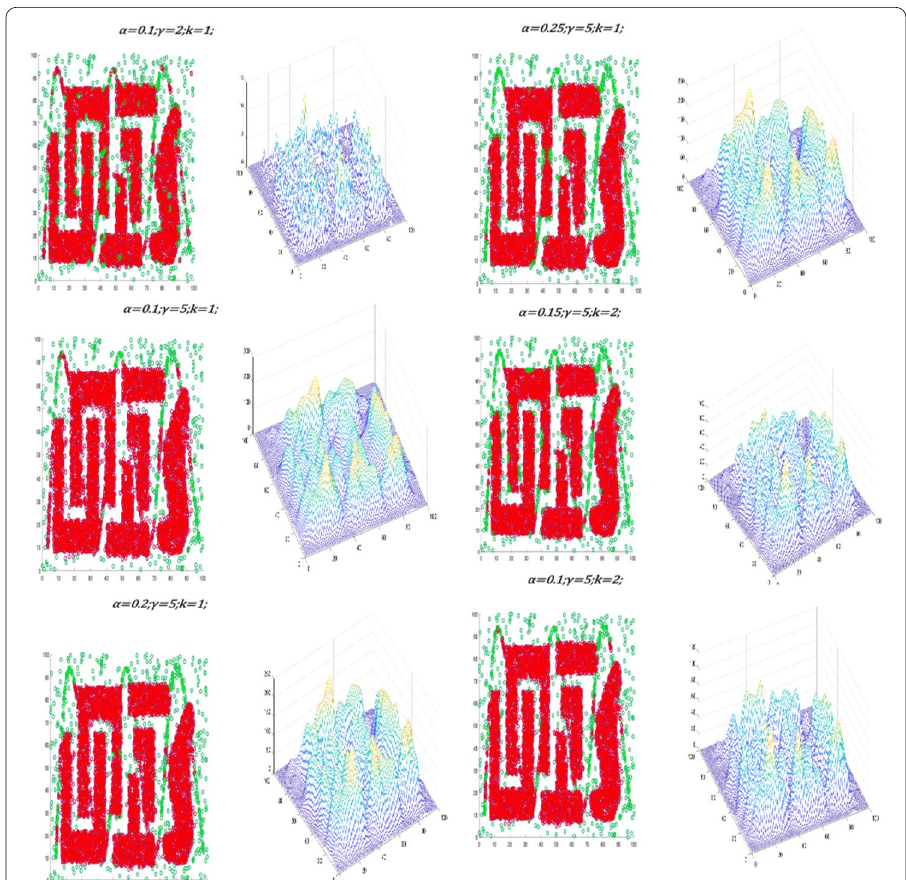
Fig. 10 Outlier detection results using scheme 2 with different values of α, γ and k. Green points represent outliers and red points represent the normal data